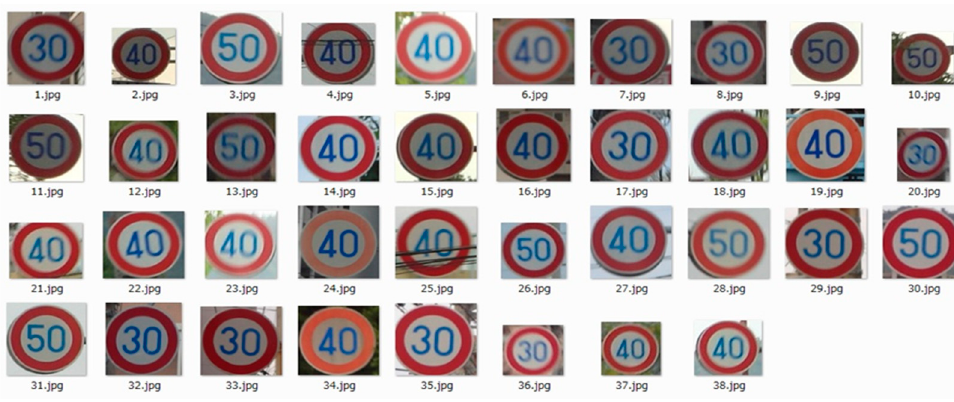
Figure 20. Effects of different lower limit values for Saturation and Value on the recognition results. Table 1. Recognition results for the four kinds of resolution.